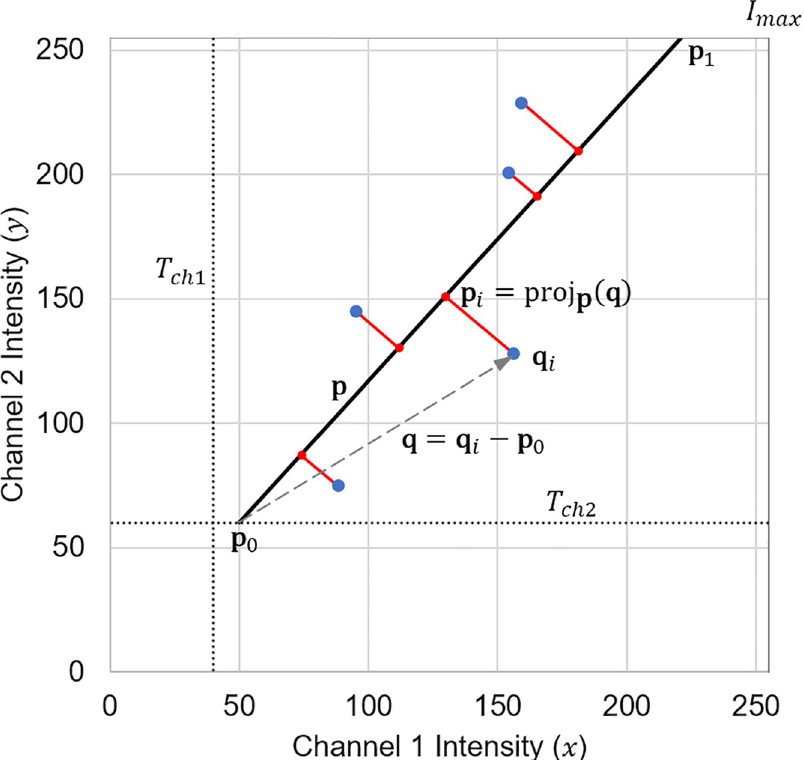
Fig 2. Projection of colocalised voxels on to the colourmap. A colocalisation intensity q subspace defined by p . A projection onto point p 0 corresponds to a colourmap value of 0, a projection onto point p 1 corresponds to a colourmap value of 1, and intermediate projections correspond to a colourmap value varying linearly between these values.